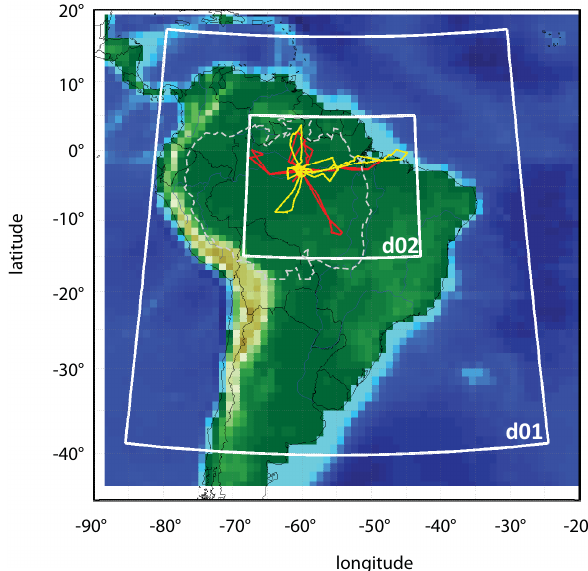
Fig. 1. Topographic map illustrating the position of the coarse do- main (d01 – 30km horizontal resolution) and the nested domain (d02 – 10km horizontal resolution). d02 covers the flight area of all flights conducted during BARCA-A and BARCA-B. The total flight track of BARCA-A is depicted in red and the total flight track of BARCA-B in yellow. The dashed line indicates the border of the Amazon lowland area as described in Melack et al.